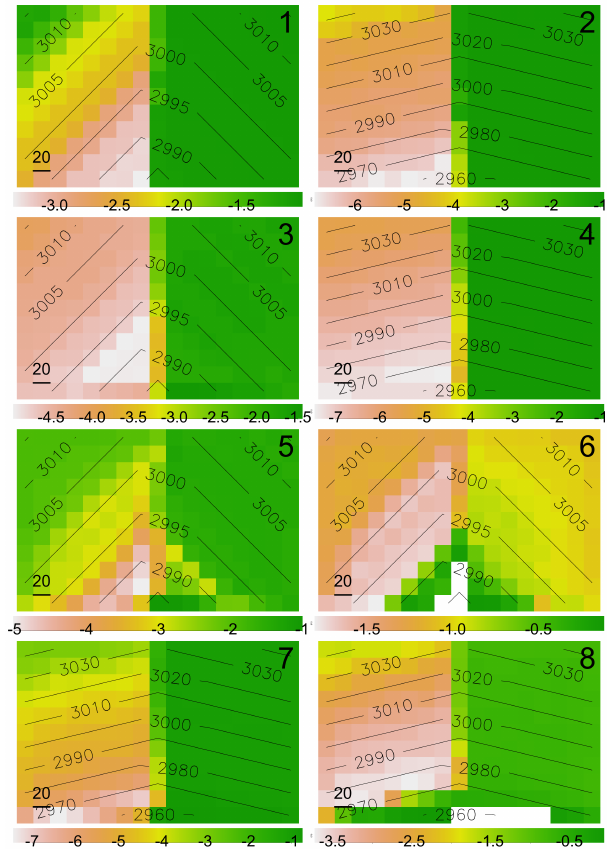
Figure 6. Distributed results: active layer depth for the simulations (5) and mean annual water table depth (in metres) (6) for the sim- ulation 5 ◦ 3-D, and active layer depth (7) and mean annual water table depth (8) for the simulation 20 ◦ 3-D. All depths and the scale are in metres, and the elevations in metres above sea level. Consis- tently with Fig. 4, north is towards the left, and the left and right slopes have respectively a south and north